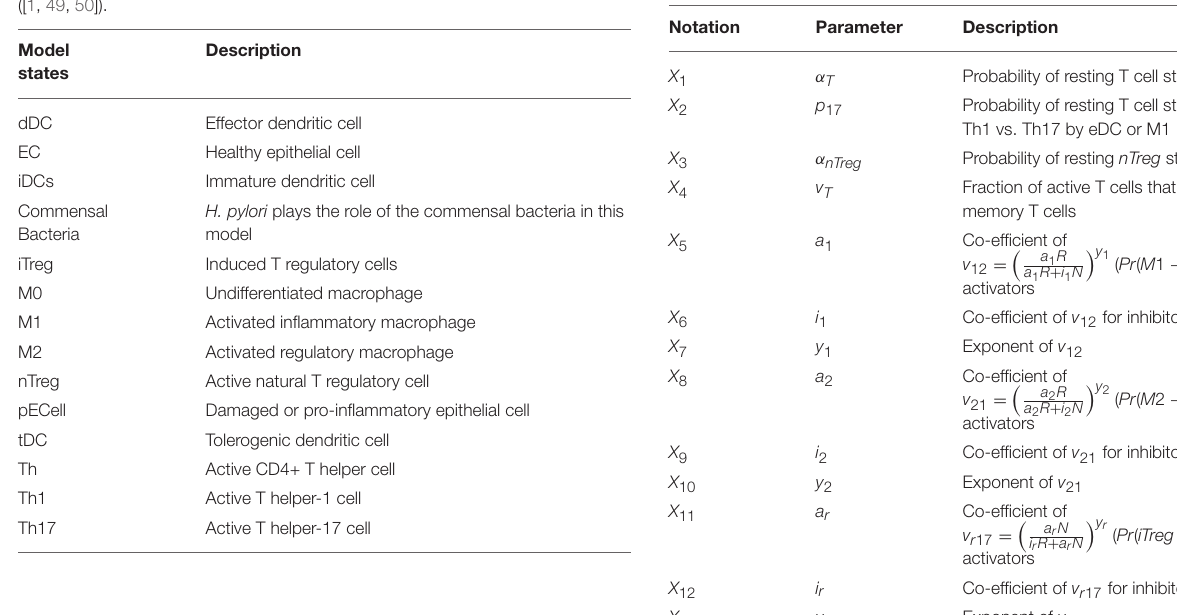
TABLE 2 | System input parameters (adapted from